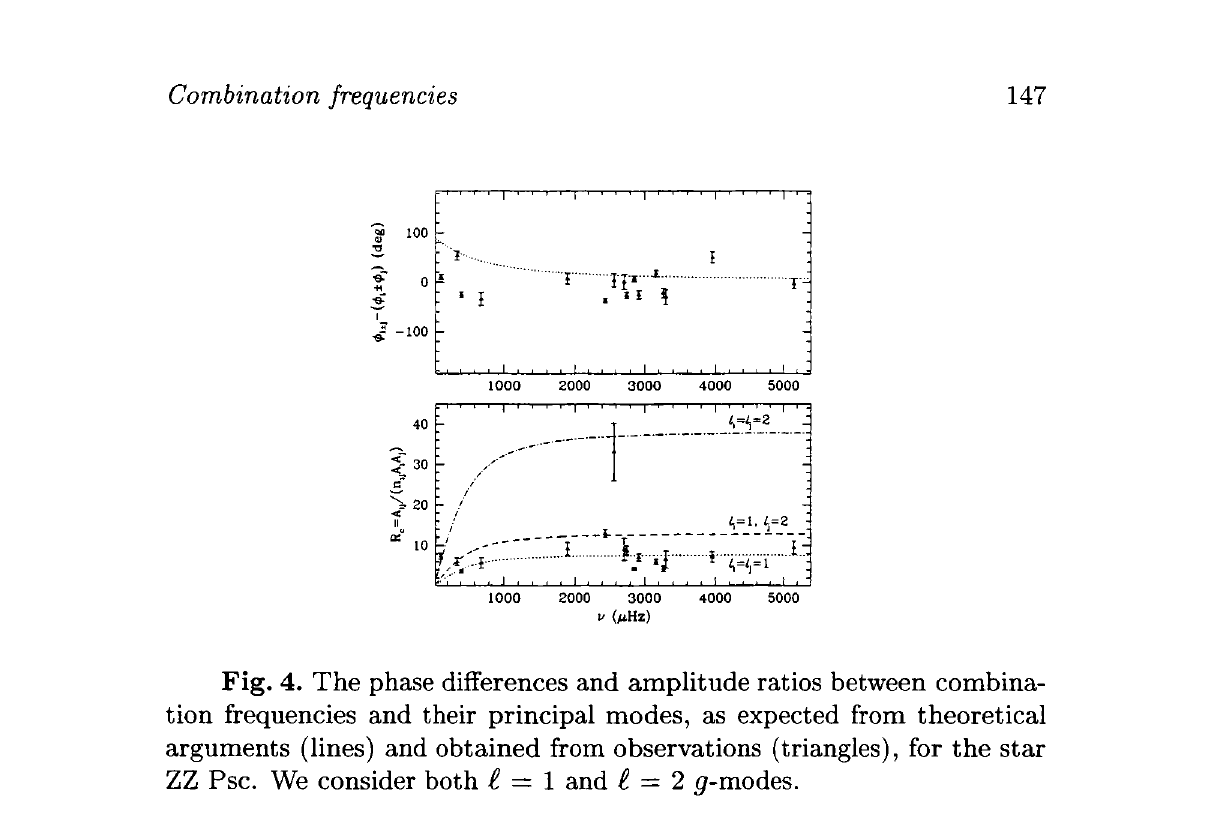
Fig. 4. The phase differences and amplitude ratios between combina- tion frequencies and their principal modes, as expected from theoretical arguments (lines) and obtained from observations (triangles), for the star ZZ Psc. We consider both I — 1 and I — 2